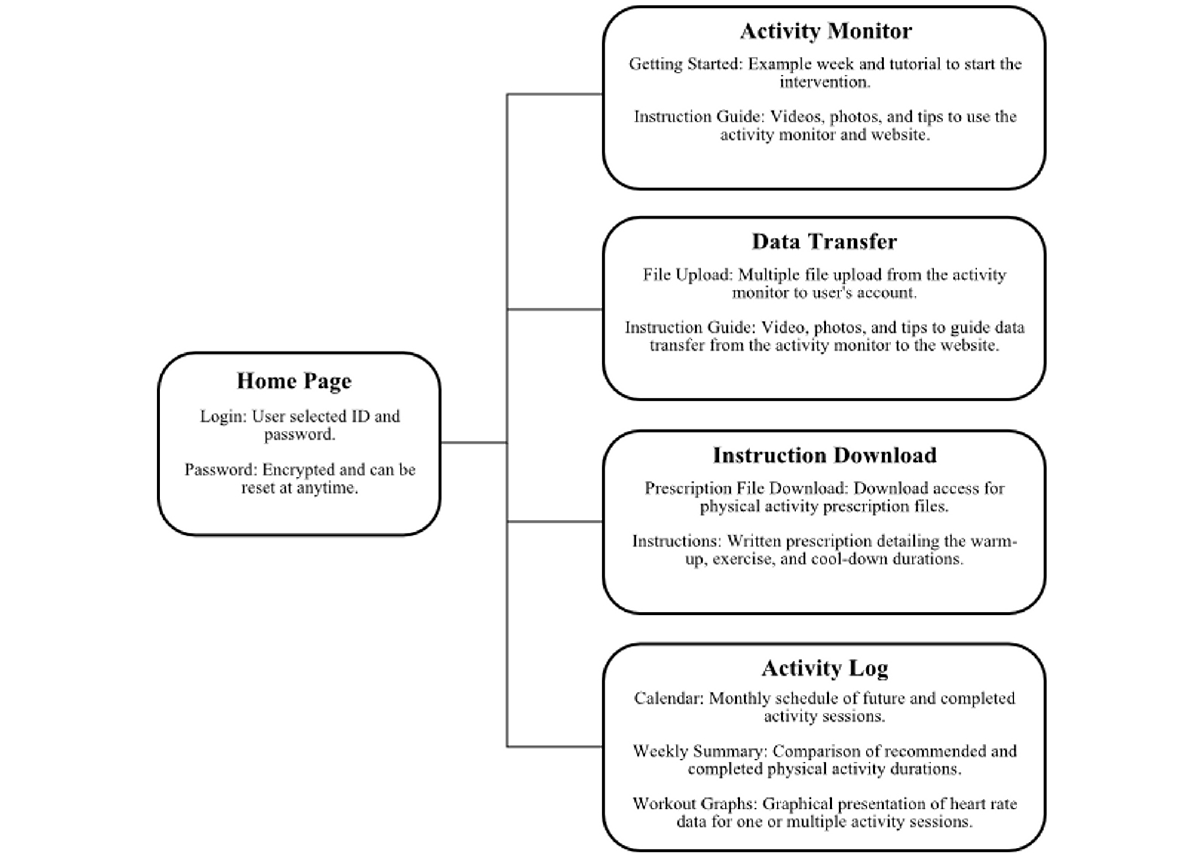
Figure 4. Description of the content and interactive features of the PPAP